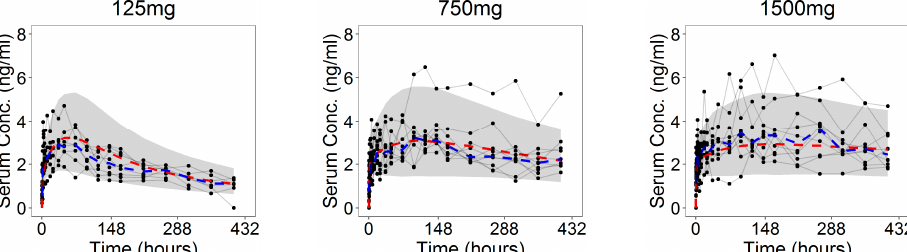
Figure A4. VPC plots (500 individuals for dose level) for the progesterone serum concentration profiles stratified on the dose level: The 90% confidence interval (grey area) is shown together with the observed data (black dots); dashed lines represent the theoretical (red) and experimental (blue) median. Table A2. Absolute %PEs on AUC[0-t] for the IVIVC P-ring model identified on dose 125, 750, and 1500 mg. Absolute %PE